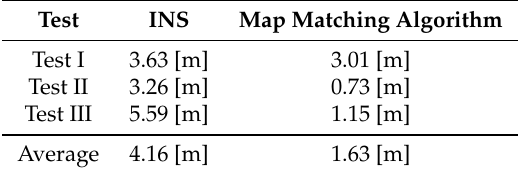
Table 2. Summary of Root Mean Squared Error for the system with and without map matching.